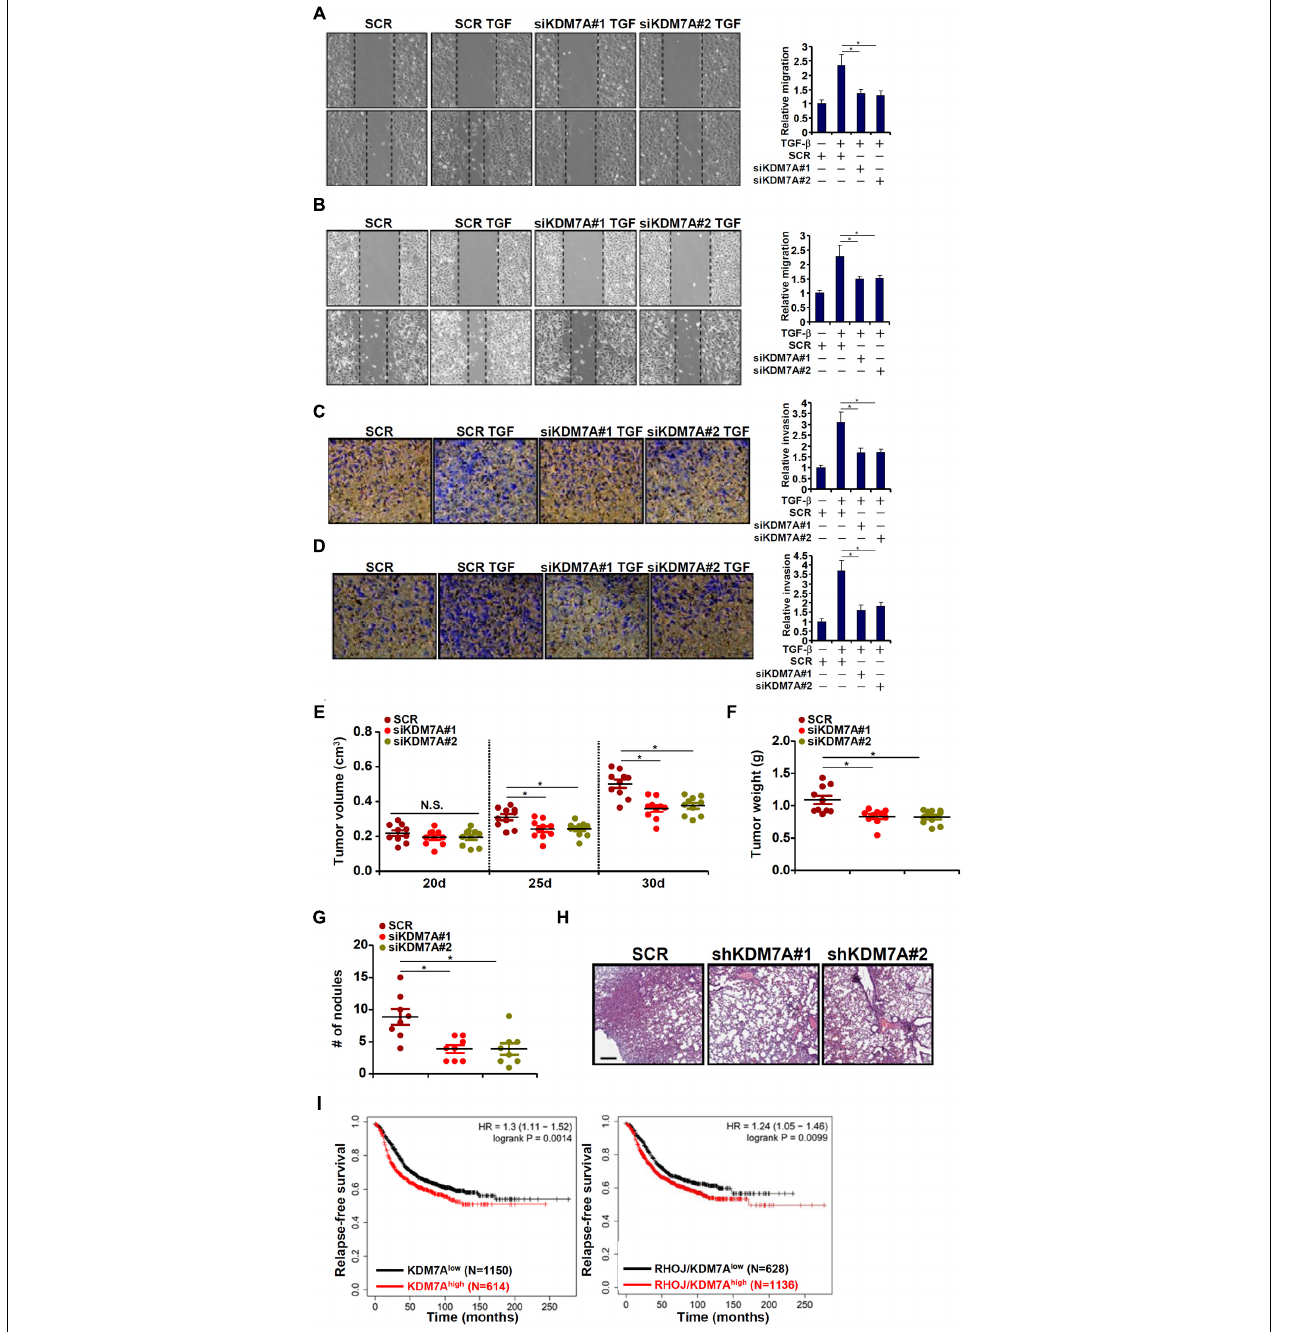
FIGURE 5 | KDM7A promotes breast cell migration and invasion in vitro and in vivo . (A,B) MCF7 cells (A) and T47D cells (B) were transfected with indicated siRNAs followed by TGF- β treatment for 48 h. When the cells reached confluence, scratch wound was created by using a sterile micropipette tip. Photos were taken at 0 and 24 h after wound creation. The changes in side-to-side wound area were measured by Image-Pro. Data were expressed as % migration compared with control arbitrarily set as 100%. (C,D) MCF7 cells (C) and T47D cells (D) were transfected with indicated siRNAs. Cell invasion was examined by transwell assay. All experiments were performed in triplicate wells and repeated three times, and one representative experiment is shown. (E,F) Heterotopic xenograft assay was performed as described in the section “Materials and Methods.” N = 10 mice for each group. (G,H) In vivo metastasis was performed as described in the section “Materials and Methods.” N = 8 mice for each group. Data represent mean ± SD. * p < 0.05, two-tailed t -test. KDM7A depletion attenuated migration/invasion of breast cancer cells in vitro and partially blockaded metastasis of breast cancer cells in vivo . (I) Kaplan–Meier plot of survival in breast cancer patients with high and low KDM7A expression either singularly or in combination of RHOJ expression. Breast cancer patients with higher KDM7A/RHOJ expression displayed poorer survival.